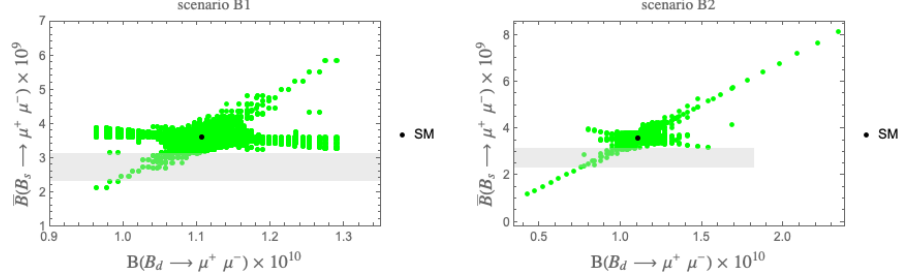
Figure 7 . Scenarios B1 (left panel) and B2 (right panel). Correlation between B ( B d ! (cid:22) + (cid:22) (cid:0) ) and (cid:22) B ( B s ! (cid:22) + (cid:22) (cid:0) ). The black dot represents the central value of the SM prediction, while the gray bands display the present experimental data reported in eq.